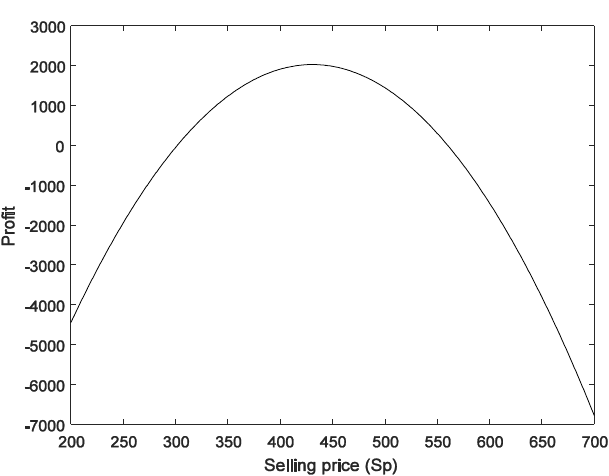
Figure 8. Profit function of Example 3 with regard to L.